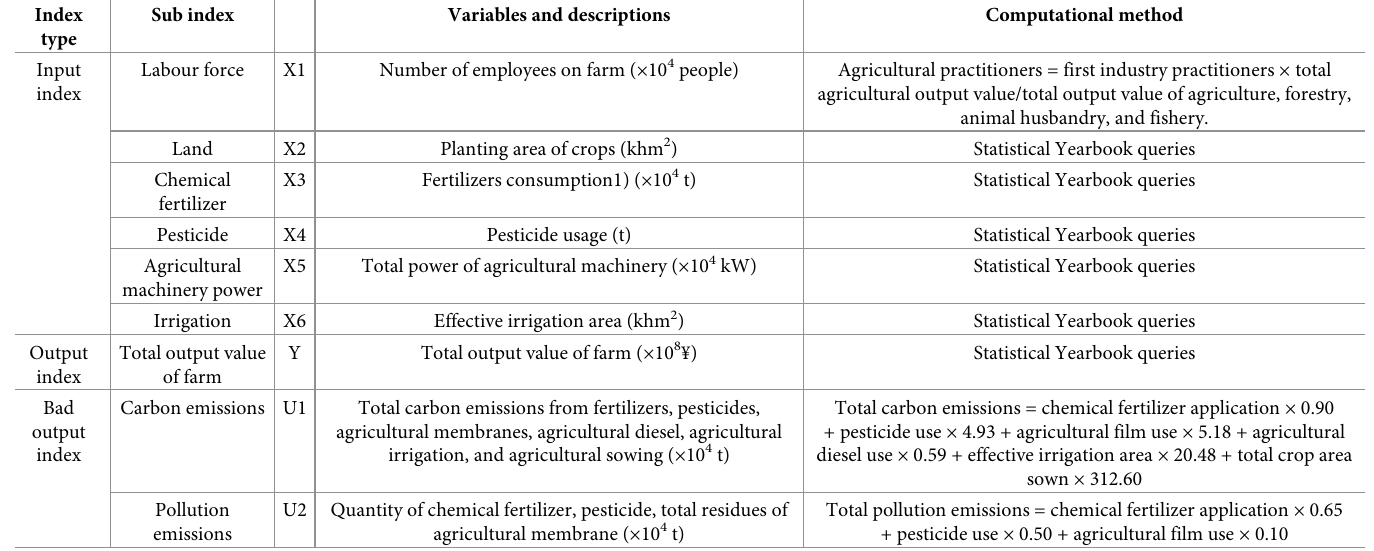
Table 2. Agricultural ecological efficiency input-output index system.